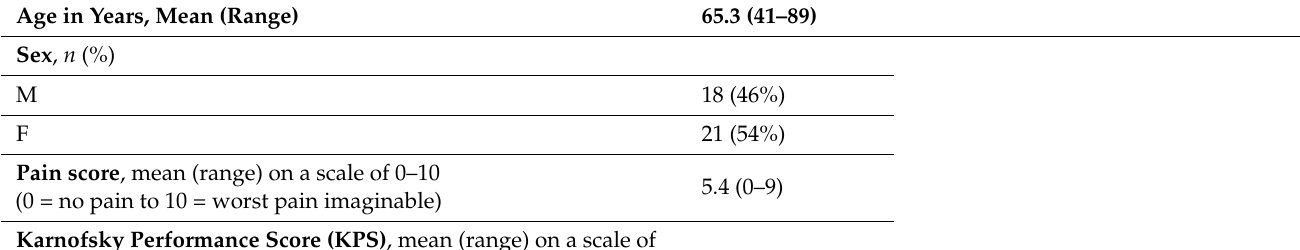
Table 1. Patient characteristics ( n =